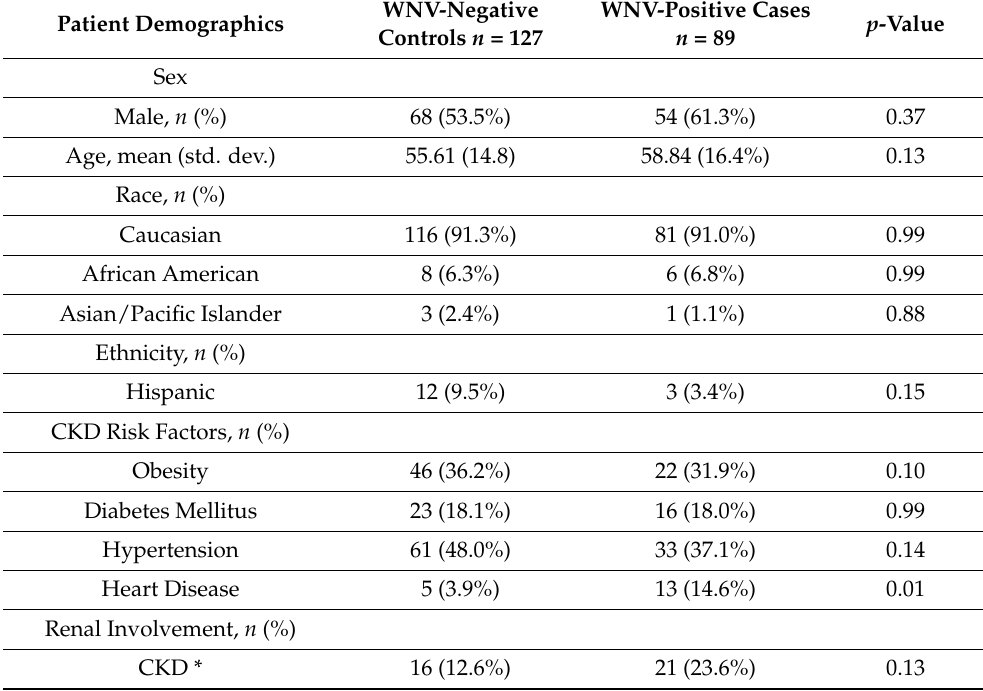
Table 1. Patient demographics.